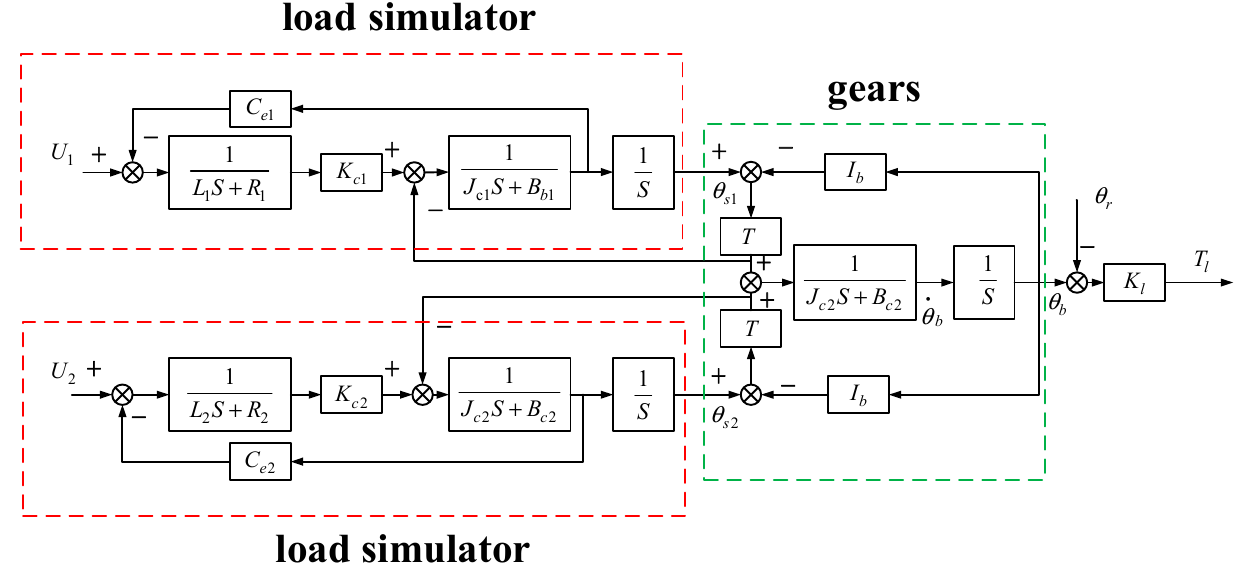
Figure 4. System structure diagram.